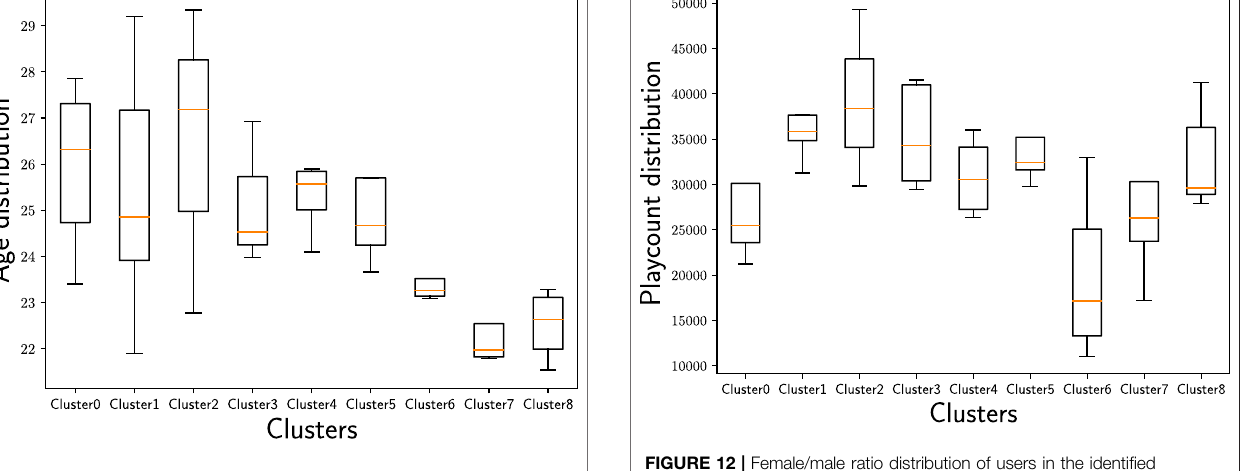
FIGURE 10 | Age distribution of users in the identi fi ed country clusters. Whilethe oldest users canbe foundin Cluster2, theyoungest canbefound in Cluster